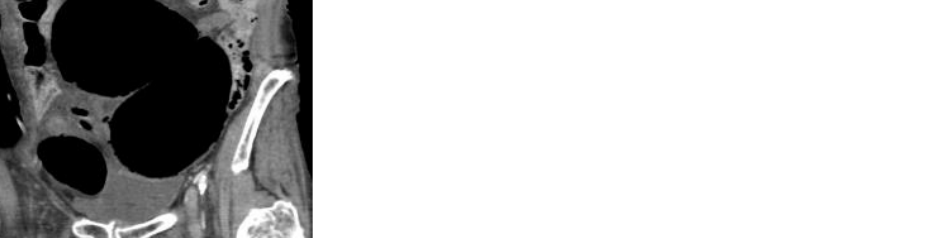
Figure 5. CT coronal image showing a grossly dilated caecum which measures more than 10 cm in diameter.